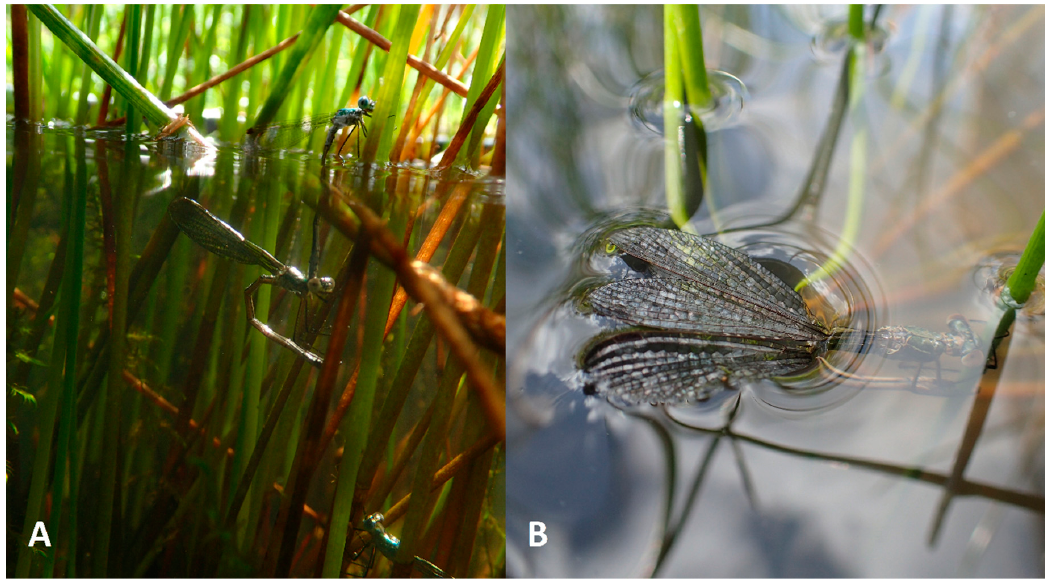
Figure 2. Tandem of Lestes sponsa ovipositing underwater in the net cage.